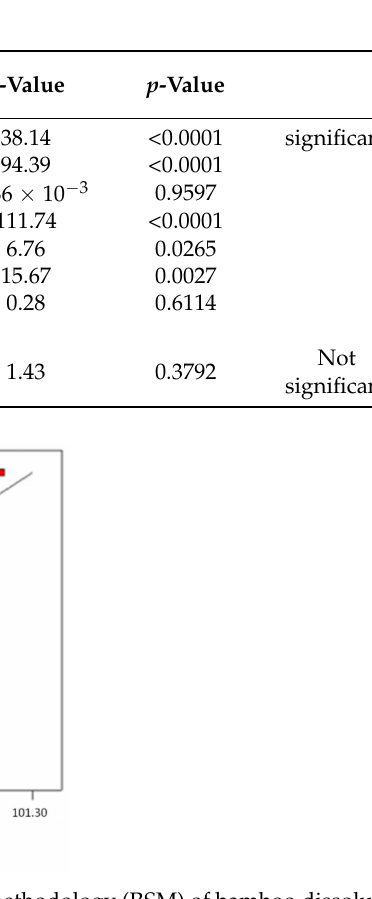
Figure 7. Actual vs. predicted plot for response surface methodology (RSM) of bamboo dissolution in